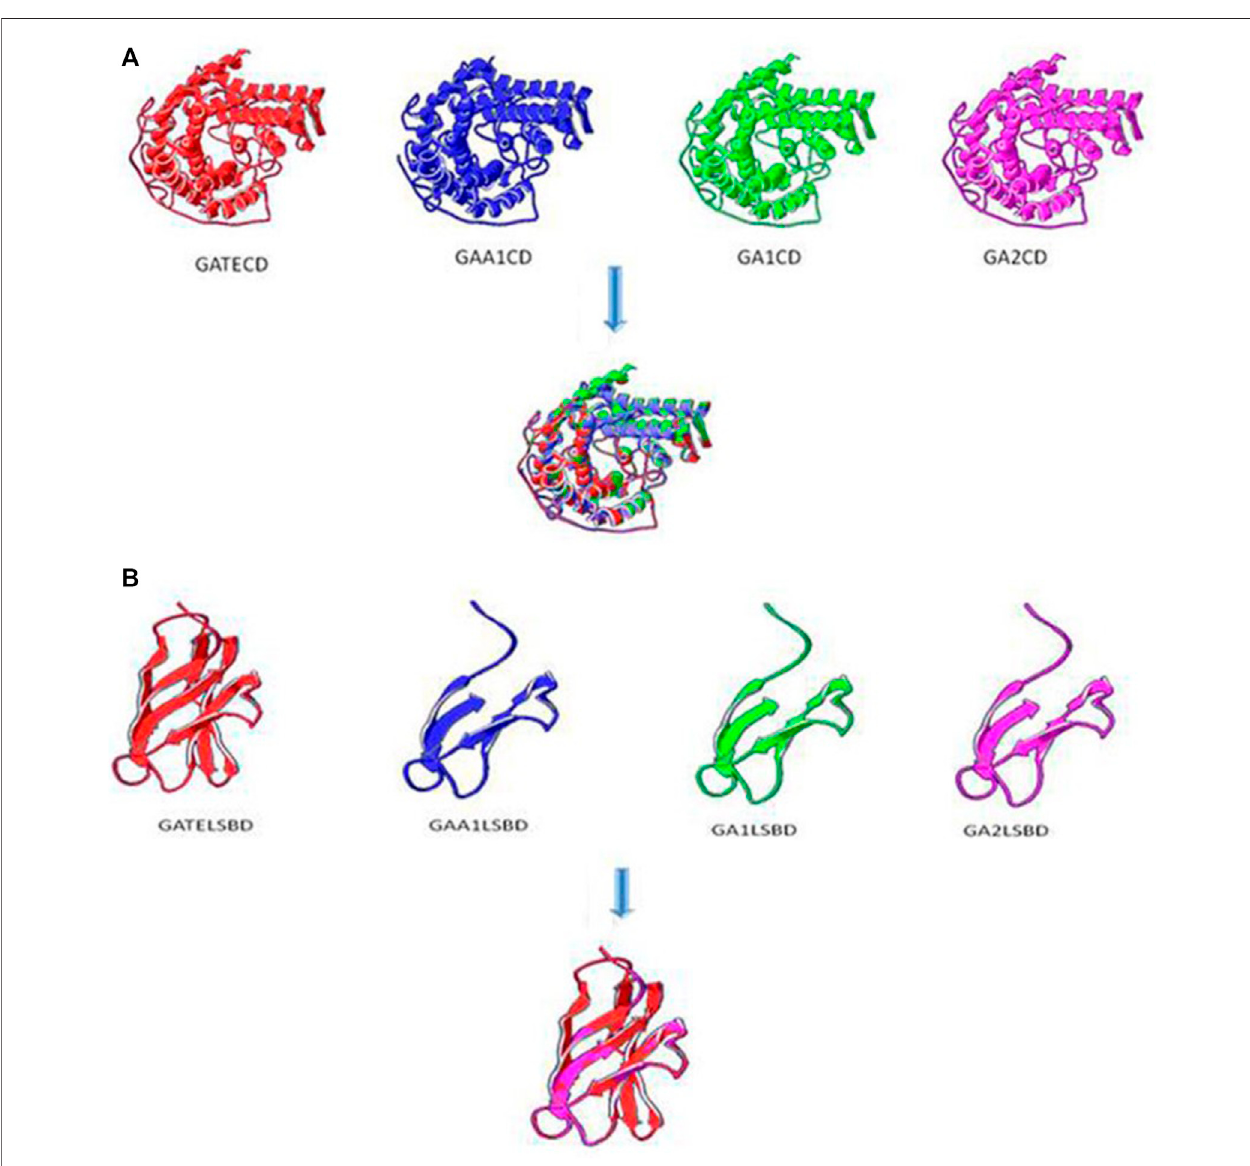
FIGURE6| TertiarystructurepredictionofCDandSBD. (A) TertiarystructurepredictionofCDdomains.ThehomologymodelingtemplateofGAA1CDhadahigh- degree homology toPDB: 3eqaAproteinand GATECD,GA1CD,andGA2CDwerenon-high-degreehomology toPDB: lgaiAprotein. (B) Tertiarystructure predictionof SBD domains with Linker. The homology modeling template of GAA1SBD, GATESBD, GA1SBD, and GA2SBD were all PDB: 11acoA protein.